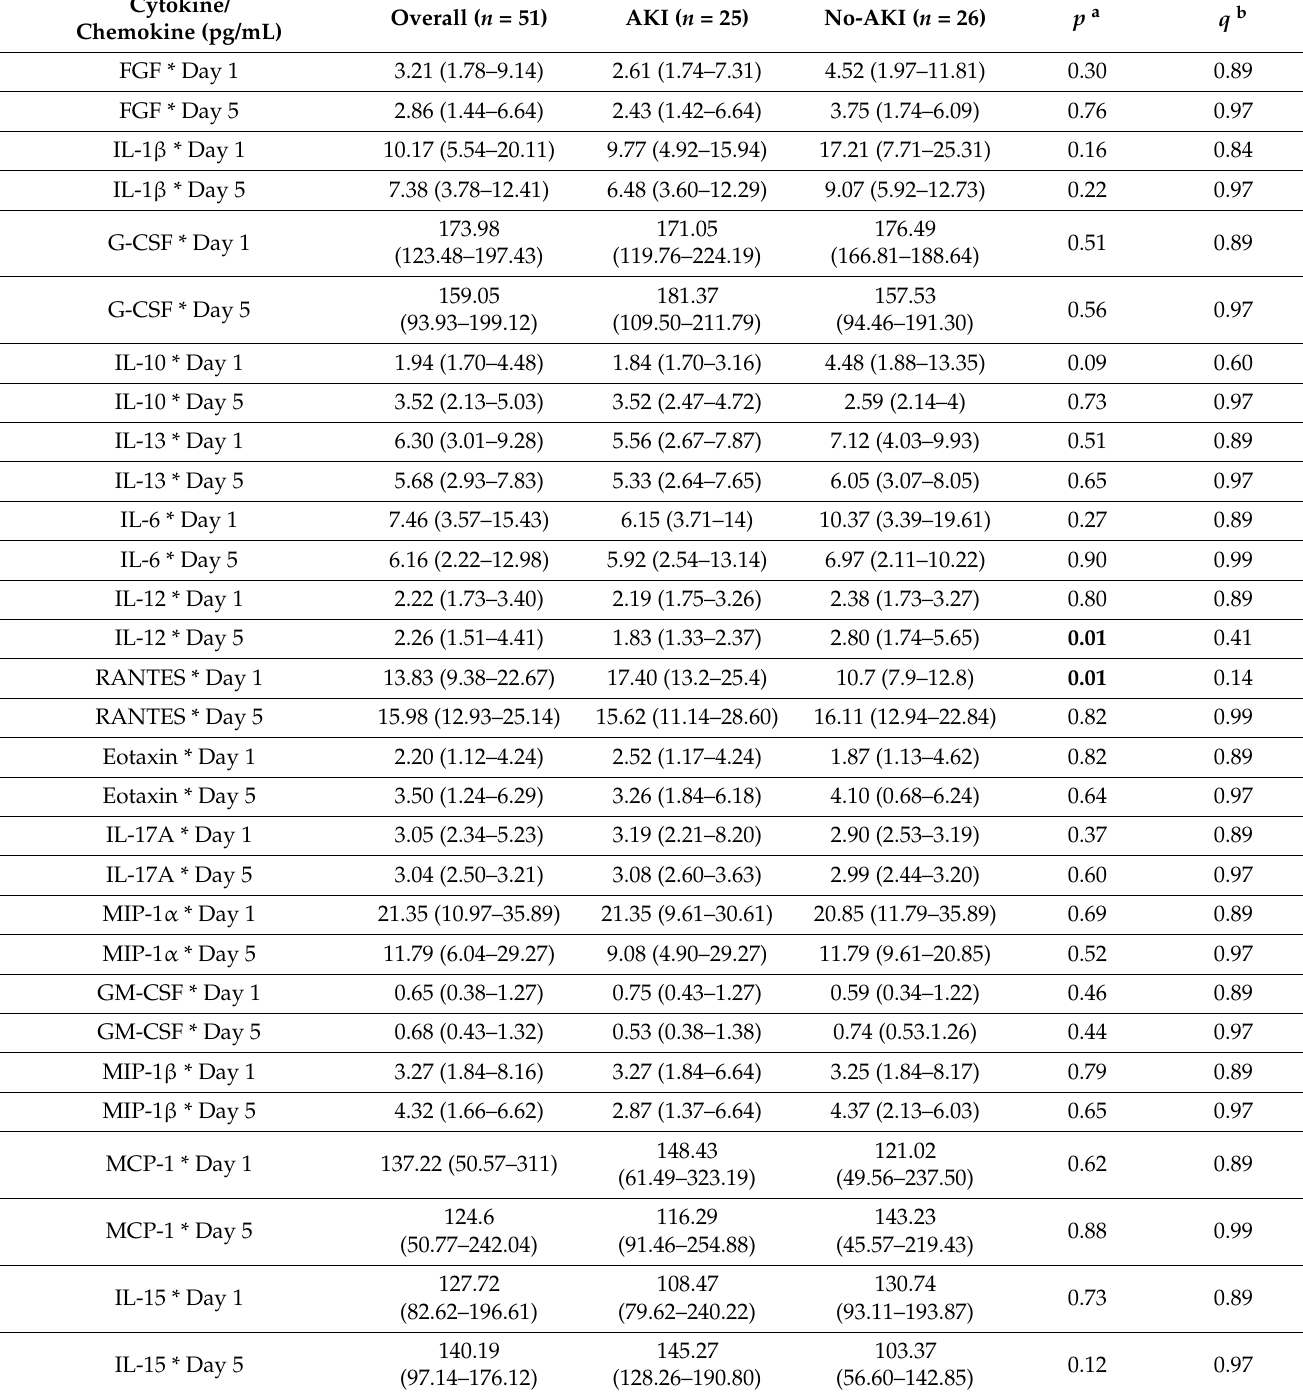
Table 2. Urinary cytokines and